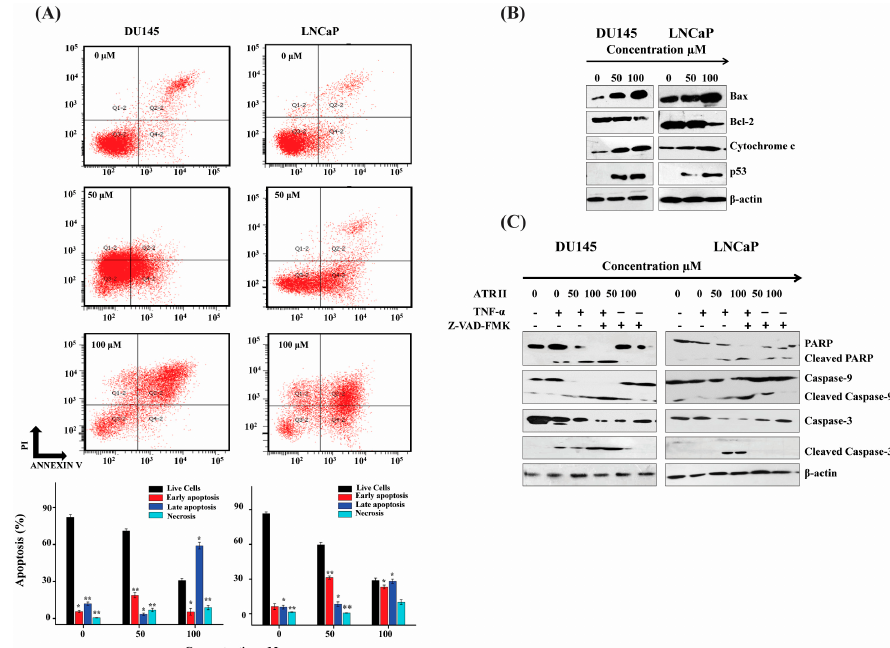
Figure 3. ATR II induces apoptosis in prostate cancer cells line through mitochondrial intrinsic pathways. ( A ) DU145 and LNCaP cells were treated, with or without ATR II (0, 50 and 100 µM for 48 h) then stained with annexin V/PI, the lower right quadrant showed V + /PI − annexin, the upper right quadrant showed V + /PI + annexin cells. Each bar represented the percentage (mean ± SD of triplicate determinations) of both annexin V + /PI − and V + /PI annexin cells (* p < 0.05; and ** p < 0.01 compared with the control). ( B ) DU145 and LNCaP cells were treated with (0, 50 and 100 µM for 48 h) ATR II then the expression of BAX , B-cell lymphoma 2 ( Bcl-2 ), p53, cytochrome C as well as β -actin were detected by western blot. ( C ) Cells were pre-incubated with 20 µM carbobenzoxy-valyl-alanyl-aspartyl-[O-methyl]-fluoromethylketone (Z-VAD-FMK) and tumor necrosis factor alpha (TNF- α ) for 30 min and subsequently treated with or without ATR II 0, 50 and 100 µ M for 48 h. The cellular proteins were extracted to detect the levels of PARP, Caspase-9, and Caspase-3 as well as β -actin as control by western